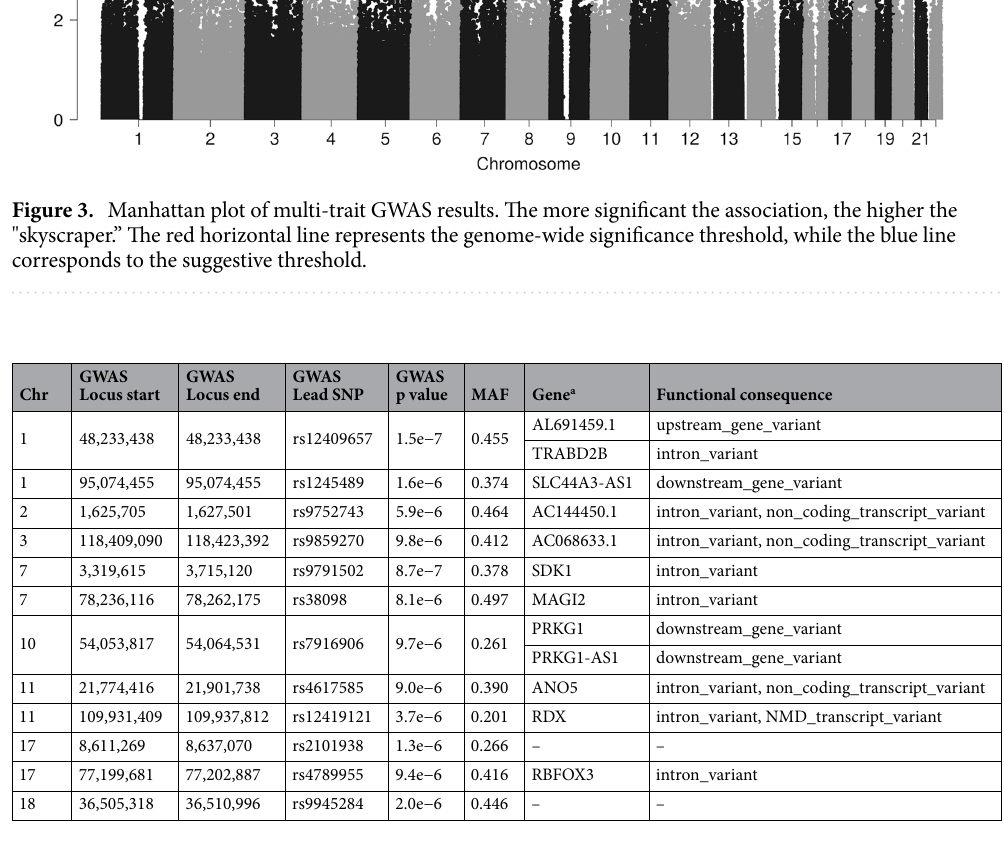
Table 3. List of identified loci via multi-trait GWAS. a Possibly related genes predicted by the Ensembl Variant Effect Predictor 47